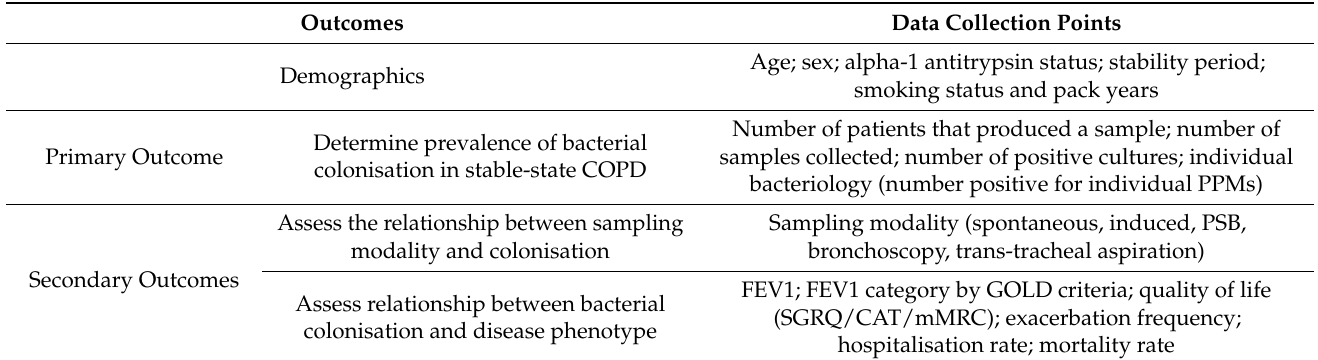
Table 1. Summary of outcomes and data collection points. CAT, COPD assessment test; COPD, chronic obstructive pulmonary disease; FEV1, forced expiratory volume in 1 s; GOLD, Global Initiative for Chronic Obstructive Lung Disease; mMRC, modified medical research council; PPM, potentially pathogenic microorganism; PSB, protected specimen brushing; SGRQ, St. George’s Respiratory Questionnaire.